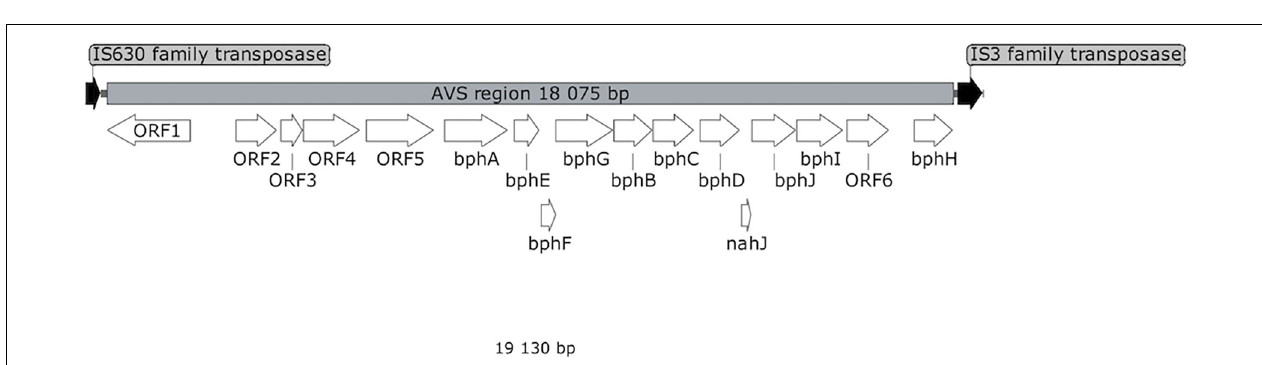
FIGURE 3 | Map of AVS region. White arrows represent ORFs discussed in the text. ORFs encoding for putative transposases are shown in